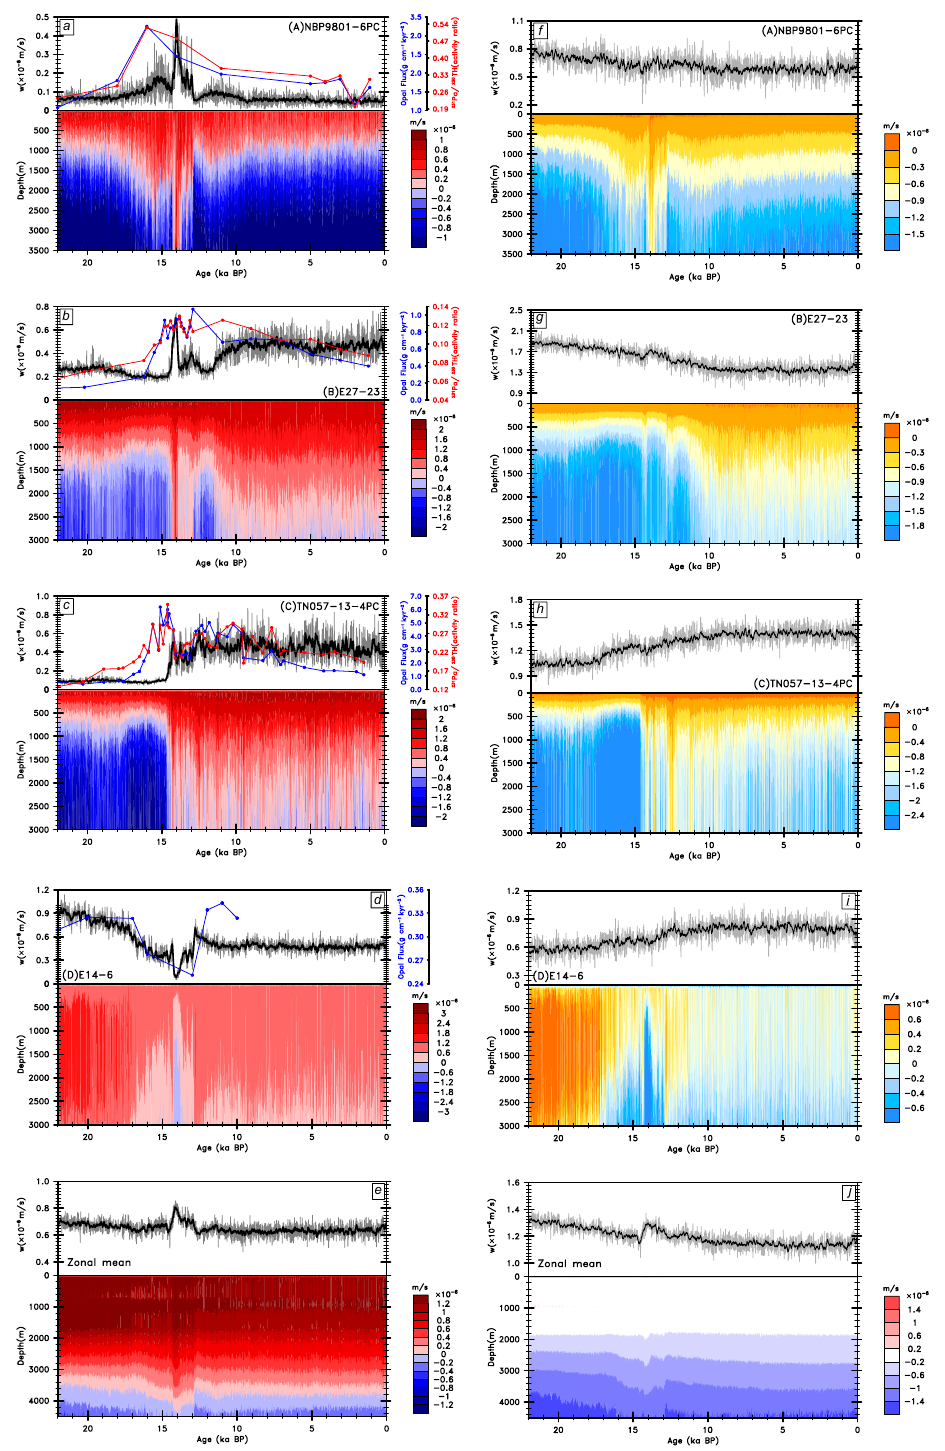
Figure 4. ( a – d ) The depth-time diagram of vertical velocity (shading in 10 − 6 m/s), column integrated upwelling (gray) and its 100-year average (black) in TraCE-21ka at corresponding grids of proxy cores A–D. In these panels, opal fluxes (blue) and the initial unsupported 231 Pa/ 230 Th ratio (red) are reproduced from previous studies [2,32]. ( e ) Similar to panels ( a – d ) but for the zonal mean vertical velocity (shading in 10 − 6 m/s), zonal mean upwelling (gray) and its 100-year average (black) over the ACC region. ( f – i ) The local Ekman pumping w Ek (gray), its 100-year average (black) and local w pva (shading in 10 − 6 m/s) at proxy cores A–D during the last 22,000 years. ( j ) Similar to panels ( f – i ) but for the zonal mean Ekman pumping (gray), its 100-year average (black) and zonal mean w pva (shading in 10 − 6 m/s) over the ACC